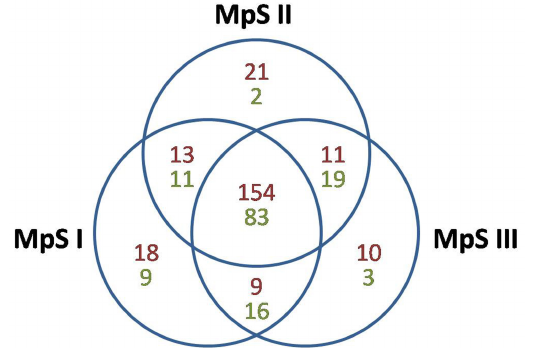
Figure 1. Venn diagram showing the distribution of miRNAs among the three developmental phases of Pongamia seeds. MpSI, the embryogenesis phase; MpSII, the seed-filling phase; MpSIII, the desiccation phase. The values in red and green indicate the numbers of conserved and novel miRNAs, respectively.